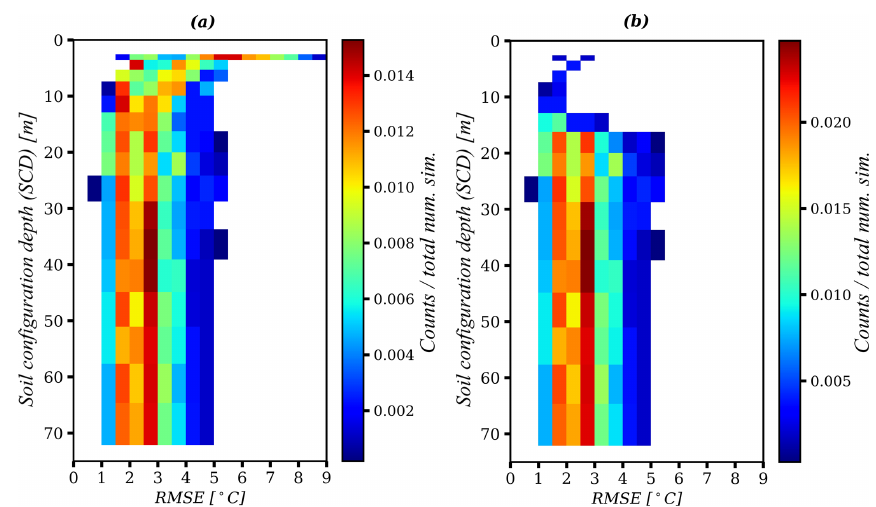
Figure 15. The 2-D histograms of SCD and RMSE for the period 1985–2000 when initialized by the bootstrap-based paleo-reconstructions. In plot (a) all the simulations are included, but in plot (b) only the simulations that have reach the h T -non-oscillation condition are included.